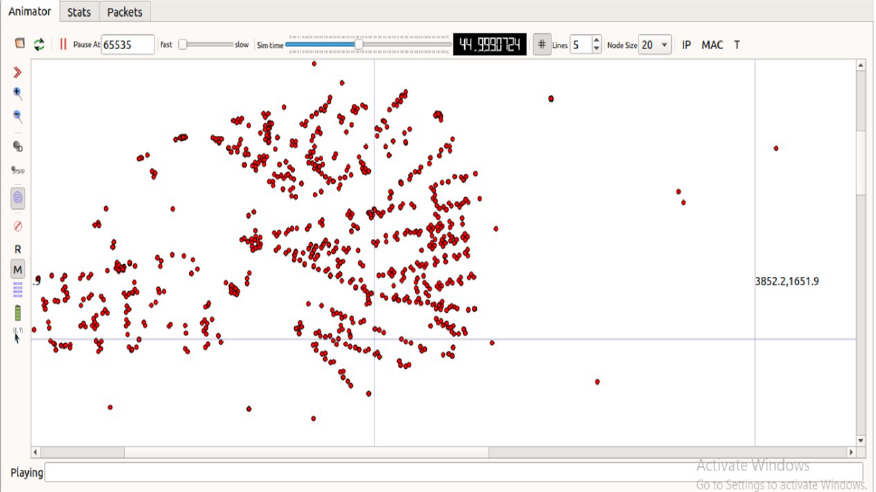
Figure 8. Stats generated in network